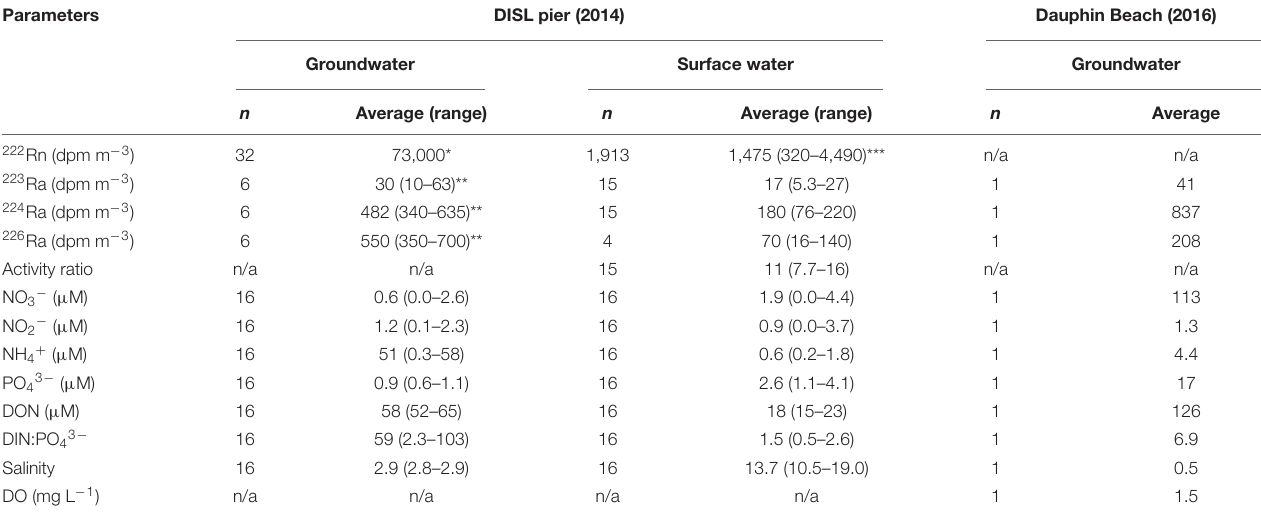
TABLE 1 | Composition of groundwater and surface water during a 24-h time series on DISL pier (2014) and grab sample on Dauphin Beach (2016).